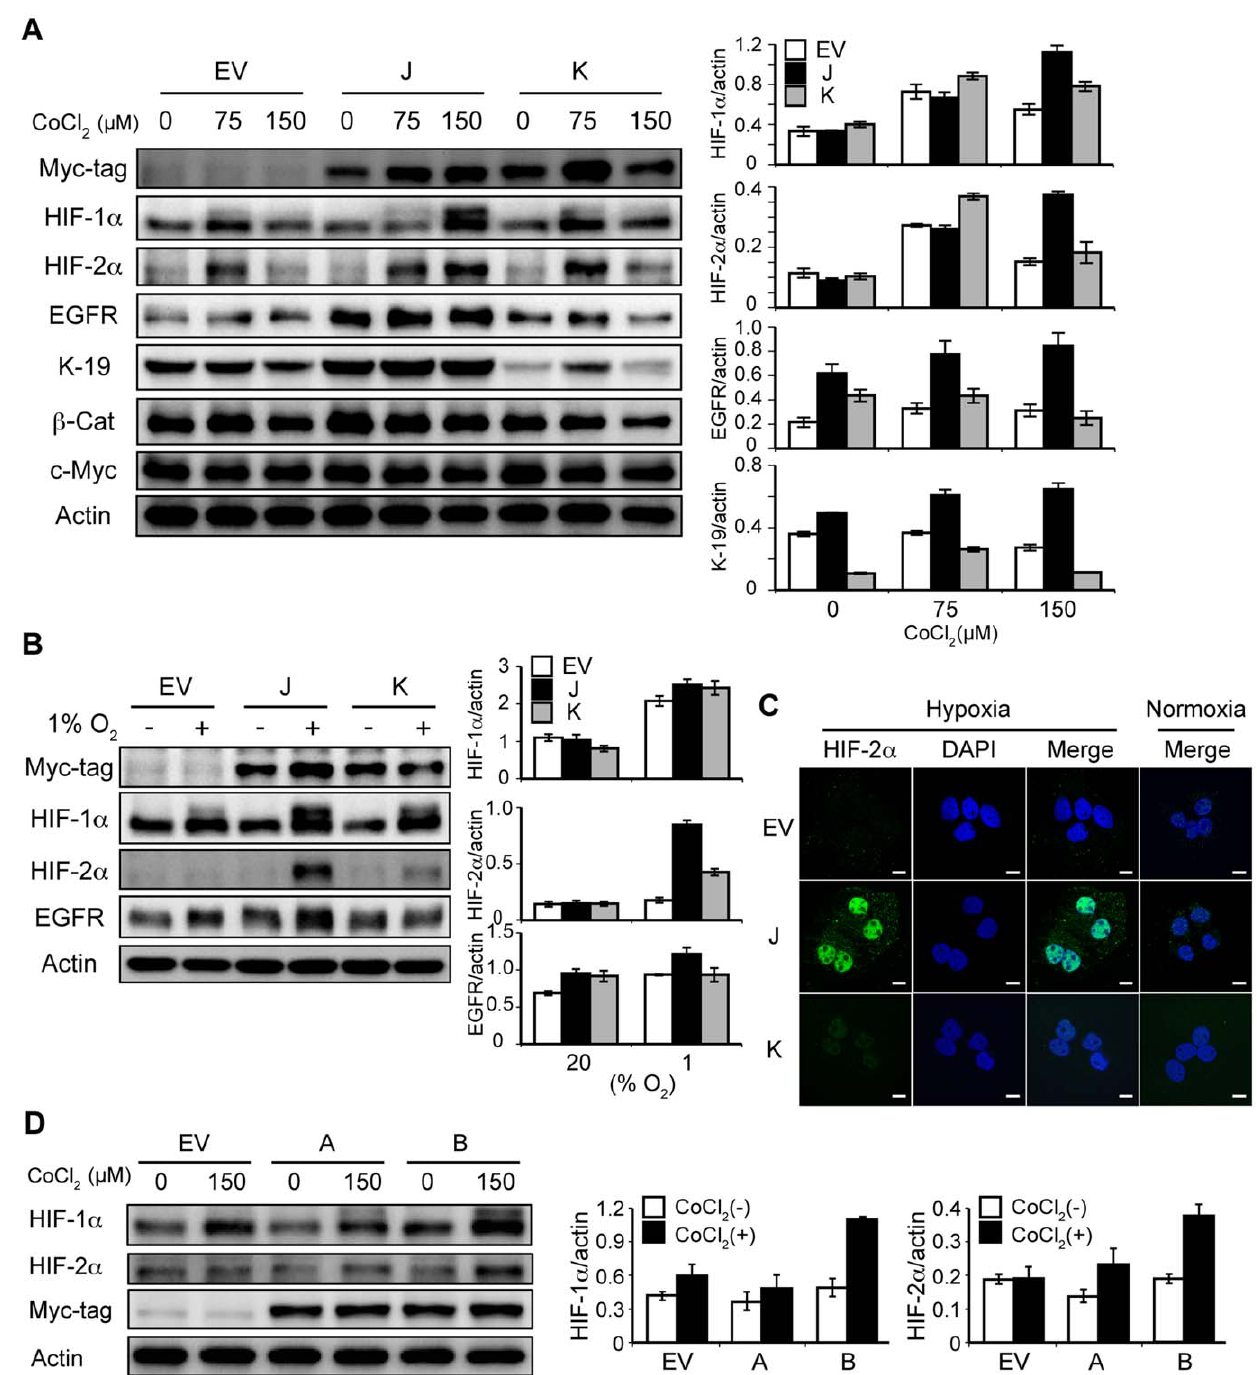
Figure 4. Loss of the SxxSS motif in TCF-4 isoforms increases expression of HIF- a s under hypoxia. (A and B) Immunoblot analysis of empty vector-transfected (EV), TCF-4J-overexpressing (J), and TCF-4K-overexpressing cells (K). The cells were treated with 0 and 150 m M CoCl 2 (A) or cultured under 1% oxygen tension for 48 hr (B). Cell lysates were subjected to detect HIF- a s and Myc-tag TCF-4 isoform protein expression. Expression levels were plotted as a ratio to actin (right panel). (C) Confocal microscopy for nuclear localization of HIF-2 a protein. Cells were treated with 0 m M (Normoxia) or 150 m M (Hypoxia) CoCl 2 and stained with an anti-HIF-2 a antibody (green). DAPI was employed for nuclear staining. (D) Immunoblot analysis of total cell lysates from cells treated with 0 or 150 m M CoCl 2 for 48 hr. A and B represent HAK-1A cells overexpressing TCF-4A (‘‘short form’’ of TCF-4K) and TCF-4B (‘‘short form’’ of TCF-4J), respectively (see Figure 2A). Note the robust increase in expressions of HIF-1 a and HIF- 2 a in B cells.